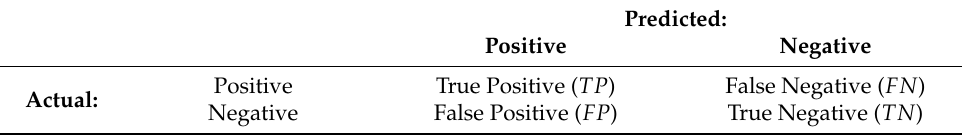
Table 5. Confusion matrix for binary